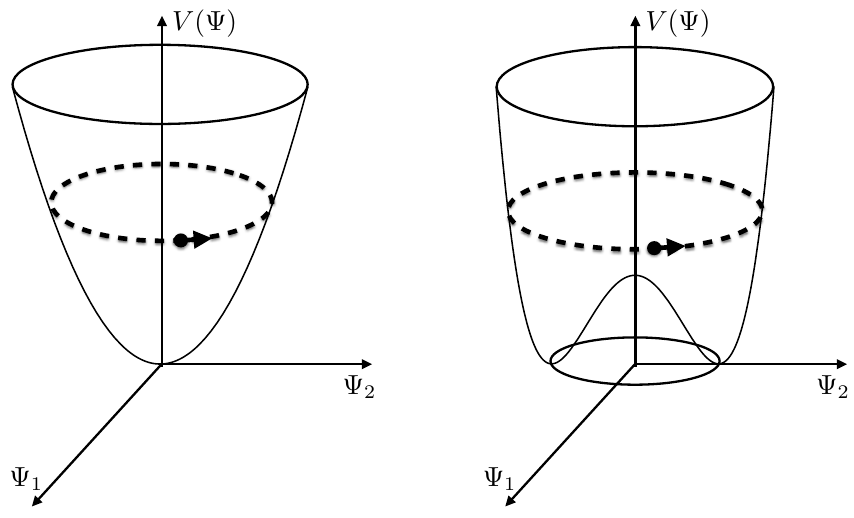
Figure 1 . Complex (cid:12)eld (cid:9) potential (2.6) for the choice of parameters ( (cid:11) > 0 ; (cid:12) = 0) (free massive case, left) and ( (cid:11) < 0 ; (cid:12) > 0) (potential with spontaneous symmetry breaking, right). The former corresponds to PPF, while the latter stands for the simplest model of k-esseence with sub-luminality, L / X + X 2 . Dynamics of PPF and k-essence is reproduced for the particular con(cid:12)guration of the complex (cid:12)eld depicted by the dashed